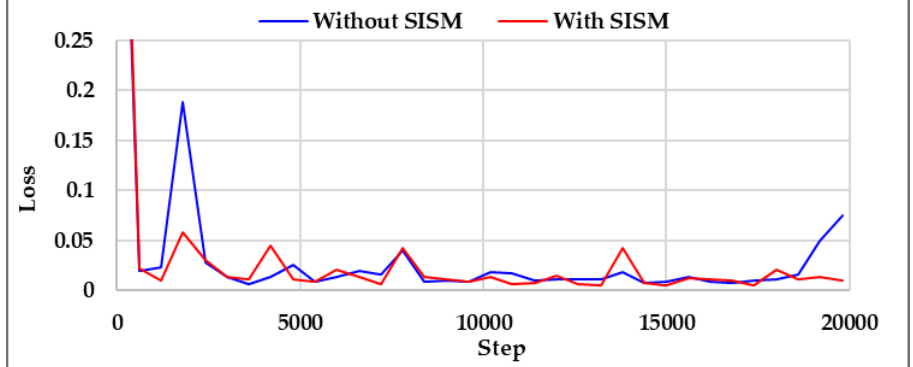
Figure 10. Training loss of different networks.